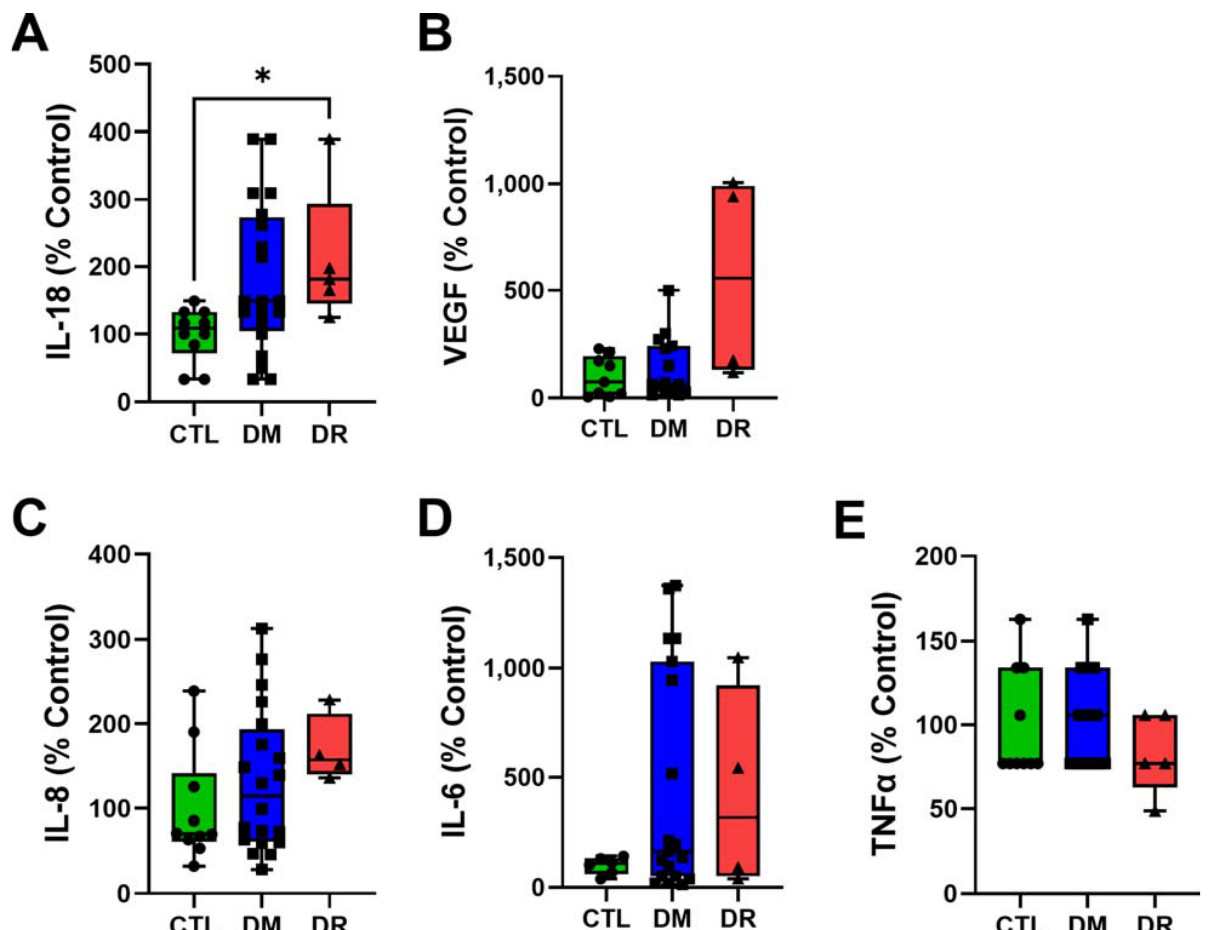
Figure 8. Vitreous IL ‐ 18 was the only cytokine showing a significant increase in DR compared to CTL. ( A ) Vitreous IL ‐ 18 showed a tendency to increase from CTL to DM to DR but a significant increase was only found in DR compared to CTL. ( B , C ) While not significantly different, vitreous VEGF and IL ‐ 8 levels appeared to increase from CTL to DM to DR. ( D ) Vitreous IL ‐ 6 levels were lower in CTL compared to DM and DR but without significant difference. ( E ) The level of TNF ‐α appeared lower in DR compared to CTL and DM but without significant difference. IL ‐ 1 β and IL ‐ 10 were below the detectable threshold. Statistical analysis was carried out using Kruskal–Wallis test followed by post hoc Dunn’s multiple comparisons test. * p ≤ 0.05. Data point of each patient in CTL, DM and DR are marked as circle, square and triangle, respectively.